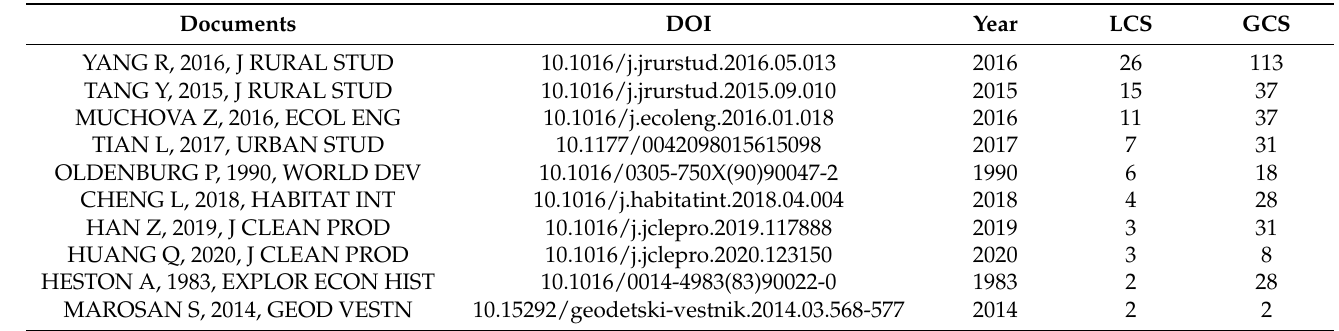
Table 5. The top 10 literatures of LCS in the field of land consolidation and rural revitalization.